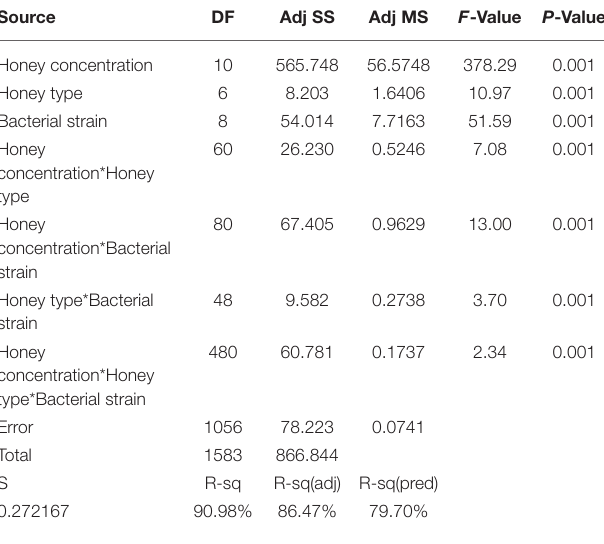
TABLE 3 | Analysis of variance (ANOVA) main effect of independent variables: tests of independent